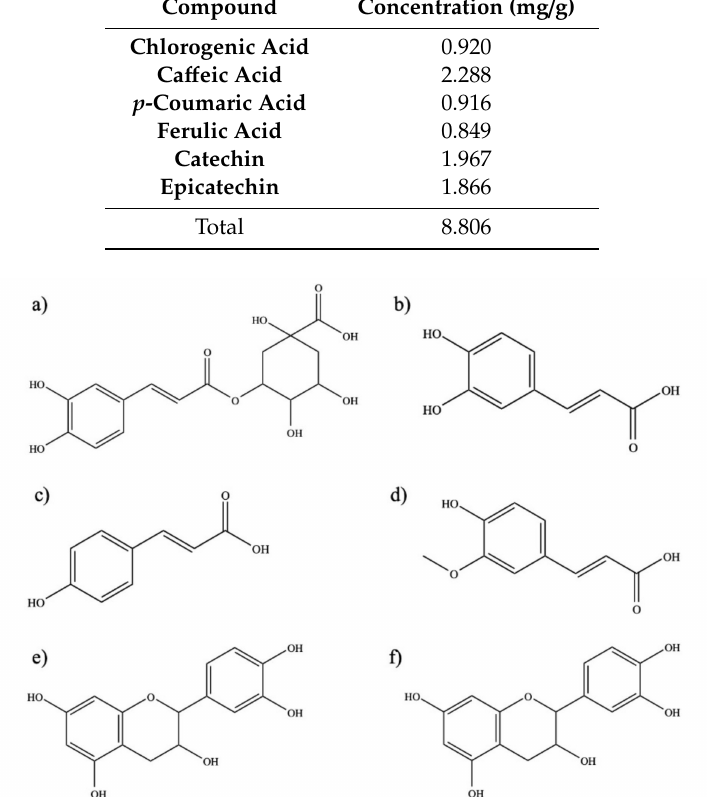
Figure 4. Phenolic compounds identified in methanolic L. tridentata extract. ( a ) Chlorogenic acid; ( b ) Ca ff eic acid; ( c ) p -coumaric acid; ( d ) Ferulic acid; ( e ) Catechin; ( f )